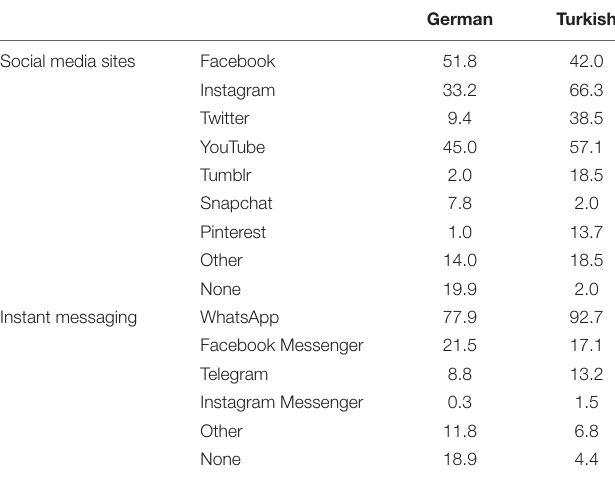
TABLE 4 | Percentage of social media sites and instant messaging applications that are used for